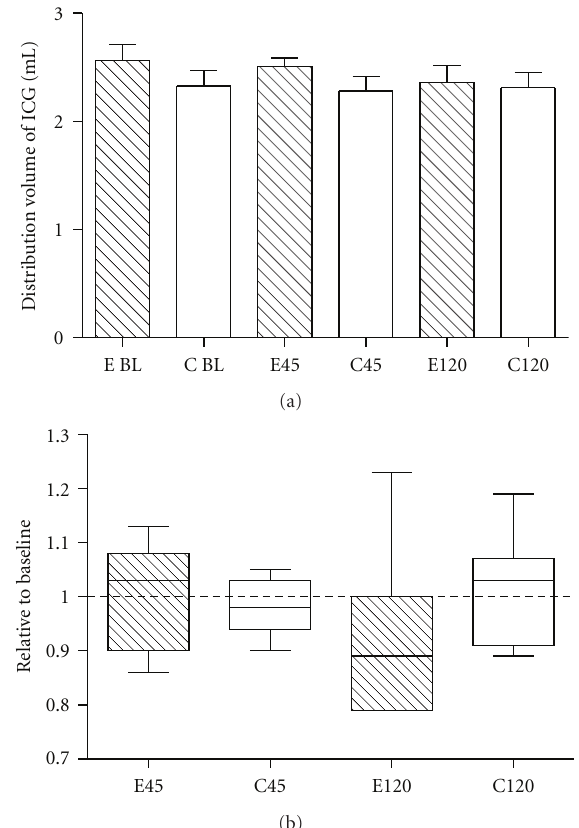
Figure 2: E ff ect of enzymatic degradation of the glycocalyx on the distribution volume of indocyanine green (ICG). (a): There was no di ff erence within or between the enzyme group (E-shaded bars) and the control group (C-open bars), at baseline (BL) and after 45 or 120 minutes. (b): There is no di ff erence in values relative to baseline for the distribution volume of ICG after 45 minutes: Enzyme group (E45) and control group (C45), and after 120 minutes, enzyme group (E120) and control group